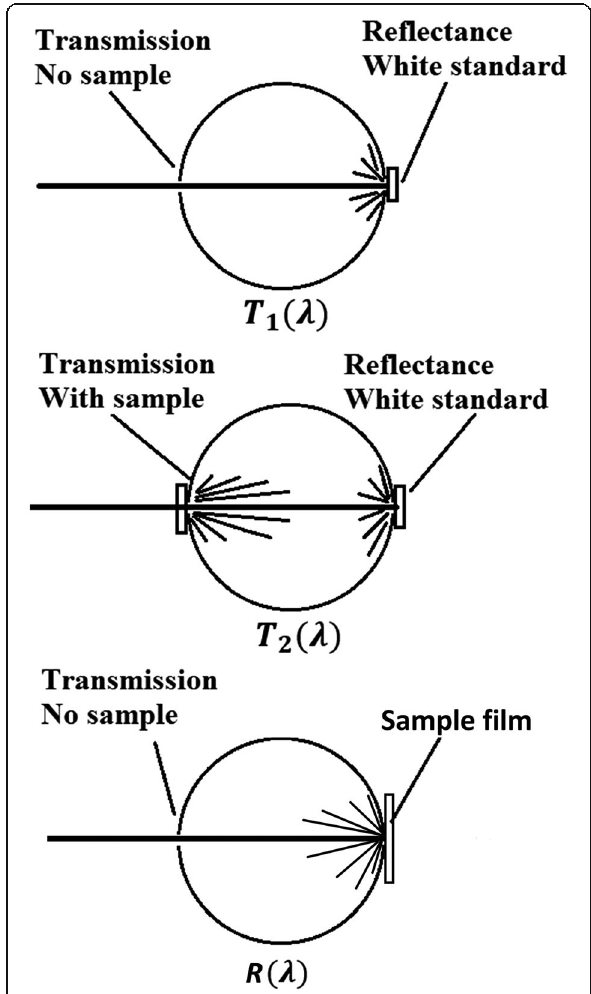
Fig. 6 Experimental setup to measure absorption. The directly measured values are T 1 ( λ ), T 2 ( λ ), and R ( λ ) where T i ( i = 1, 2) or R ( λ ) is proportional to the amount of light trapped in the integrating sphere. The absorption is deduced from these measured values. This setup is a simplified version of the one reported in reference